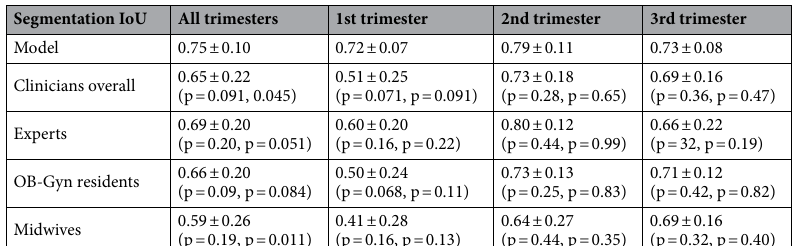
Fig. 2 show that when the model detects placental tissue, it consistently performs better and more robustly than all groups of experts (Supplementary Information).